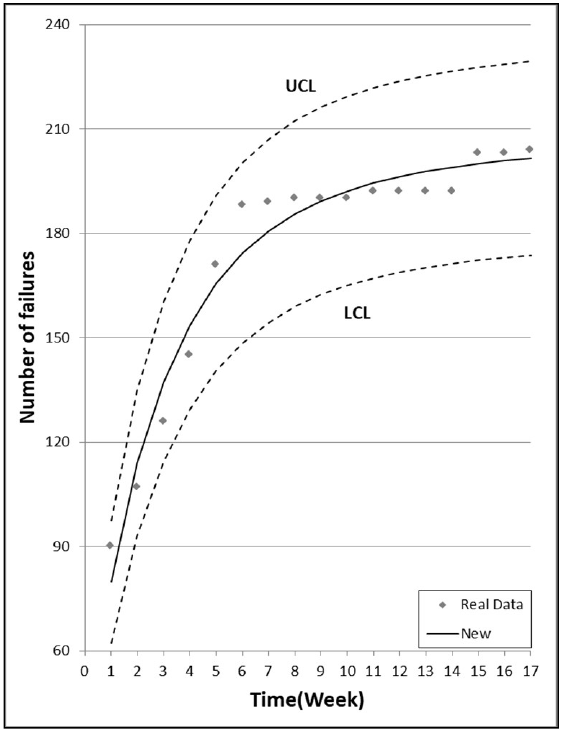
Figure 6. 95% confidence limits of the newly proposed model for DS2.